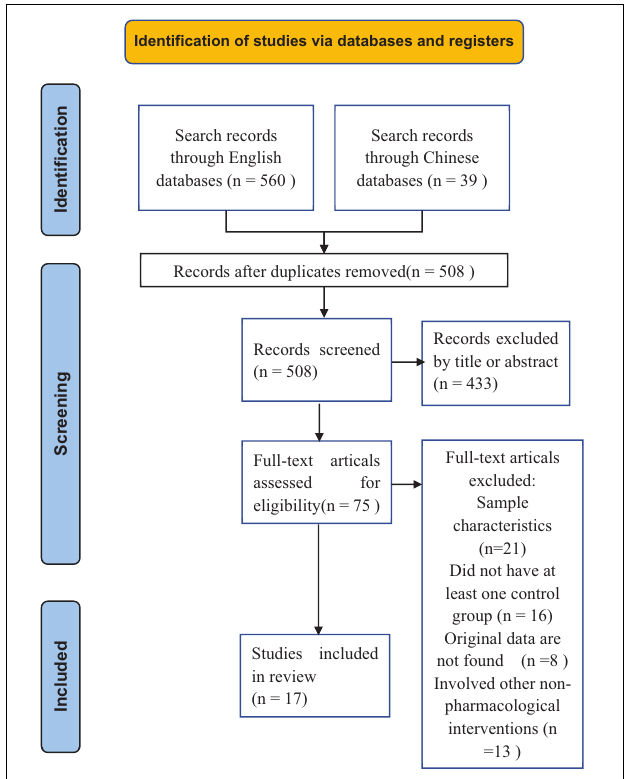
FIGURE 1 | PRISMA flow diagram of selection of